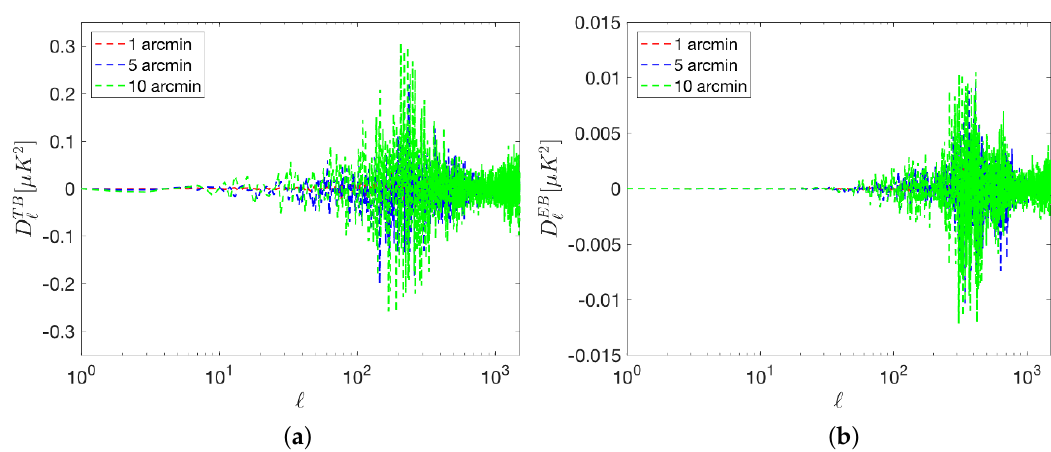
Figure 5. TB ( a ) and EB ( b ) signals produced by random pointing errors of 10 (green), 5 (blue) and 1 (red)